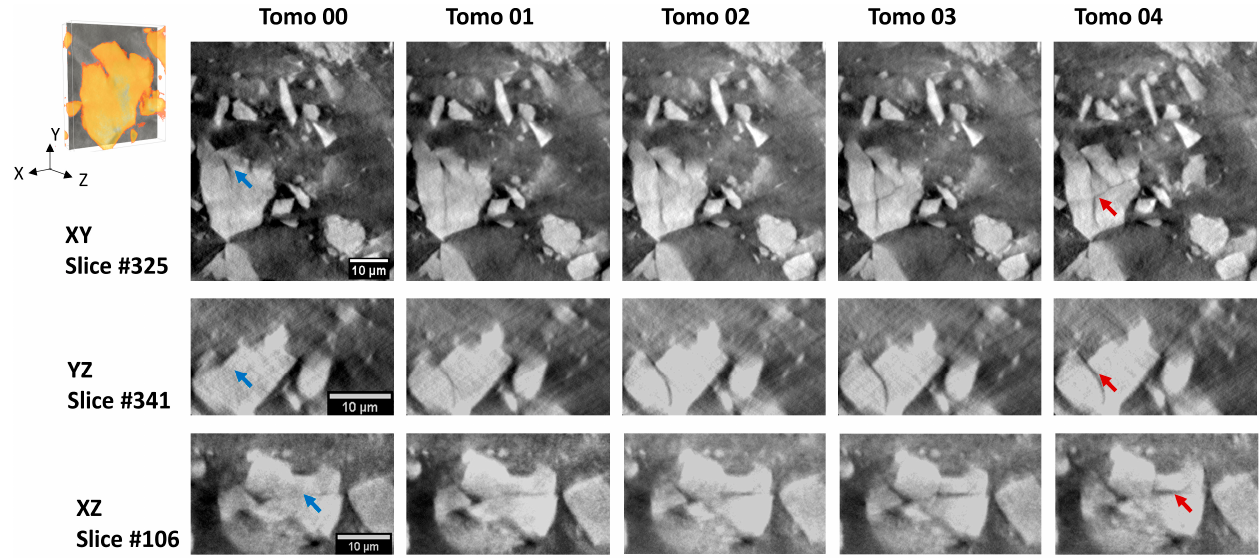
Figure 3. X-ray tomography cross-sections showing the microcrack formation and growth process in one of the damaged particles. Cracks that are (semi)quantitatively analyzed on Figure 4 are marked with arrows. The blue arrow shows the initial state of the crack, and the red arrow shows the final state.